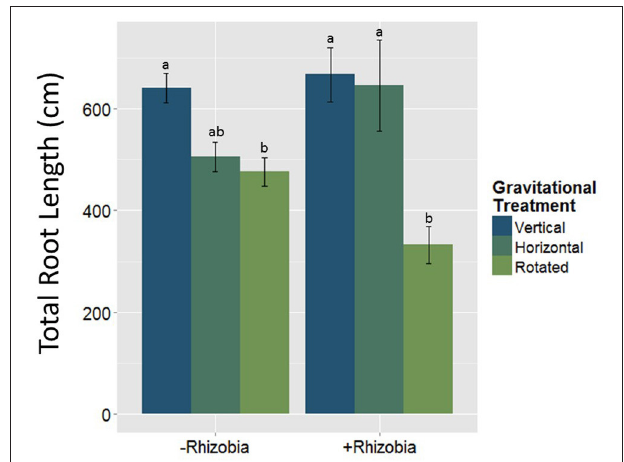
FIGURE 4 | The interaction between rhizobia × gravitational treatment in total root length. Letters indicate significance among nodulated treated plant ( + Rhizobia) and non-nodulated plants (-Rhizobia). Plants treated with rhizobia ( n = 69 ) had significantly less total root length ( p < 0.05 ). Total root length is significantly reduced in clinorotated plants inoculated with rhizobia ( n = 30 ) compared to the vertically and horizontally grown plants ( p < 0.05 ; n = 19 and n = 20 ). The letters above each standard error bar denote significance between rhizobia treatments.